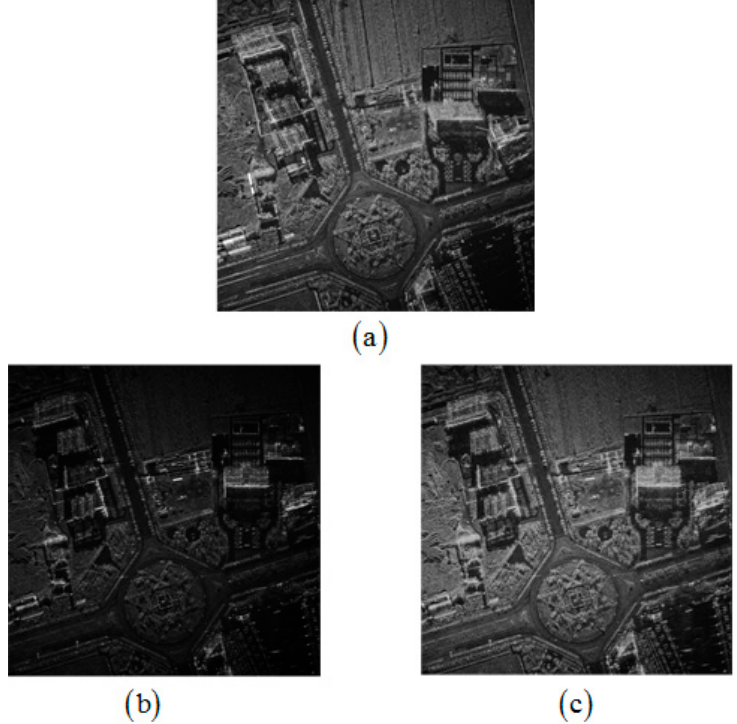
Figure 12. The grey scale between different frame images. ( a ) The reference image. ( b ) The original image. ( c ) The original image with energy balance.